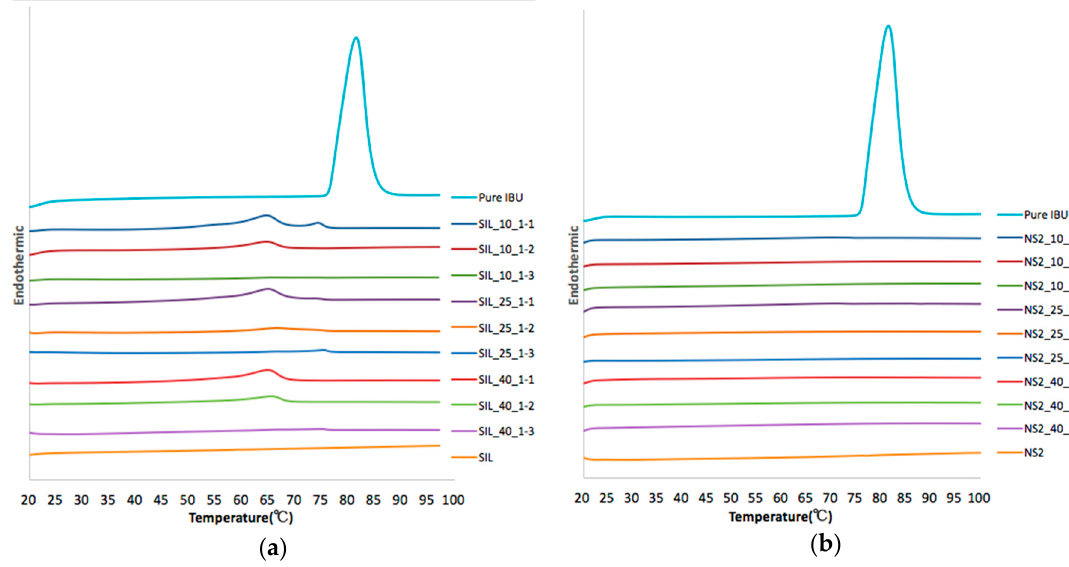
Figure 4. Differential scanning calorimetry (DSC) results of drug-loaded ( a ) S244FP and ( b ) NS2 under different drug loading conditions (refer to Table 1 for sample details).